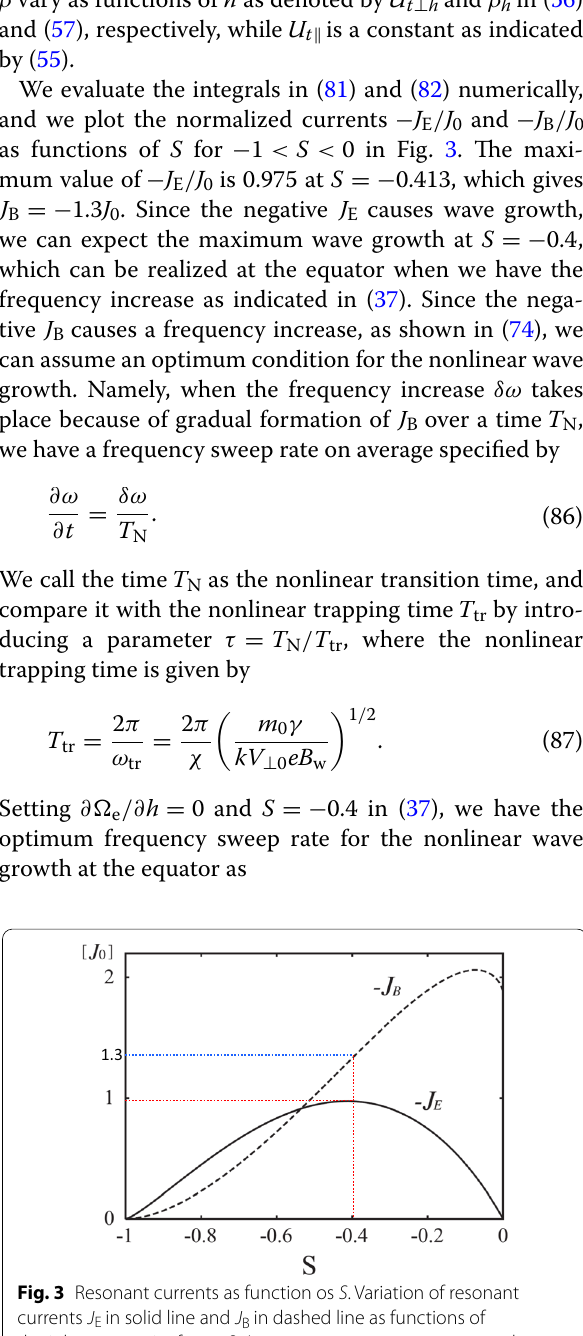
0.975 J 0 and 0.413 , J E = − = −